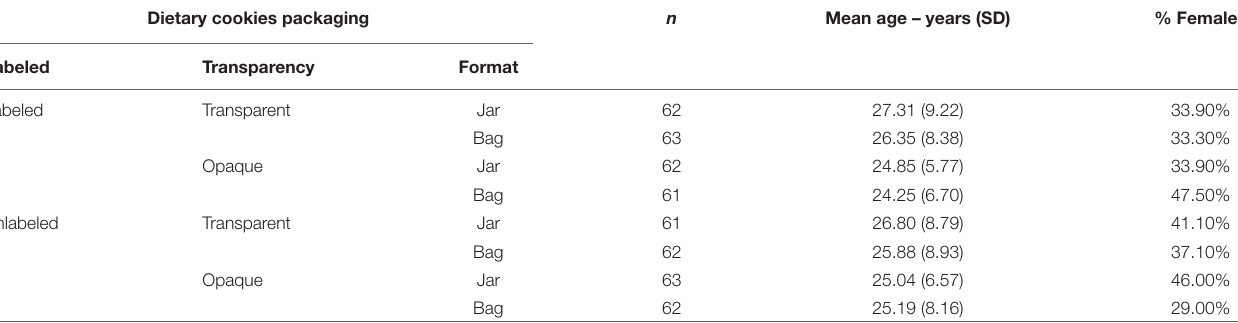
TABLE 1 | n, mean of age (with corresponding SD), and % of females, for each between-participants packaging sample. Dietary cookies packaging n Mean age – years (SD)